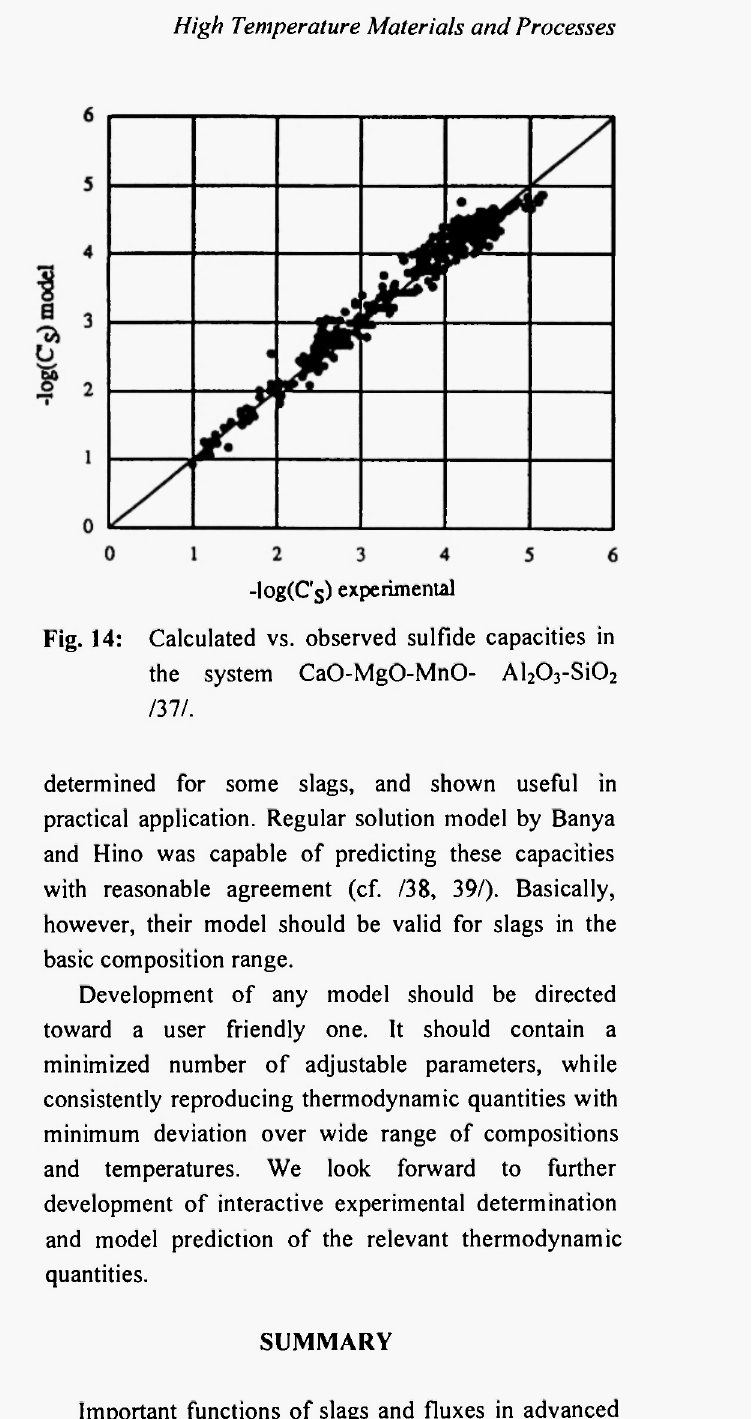
-log(C's) experimental Fig. 14: Calculated vs. observed sulfide capacities in the system CaO-MgO-MnO- Al 2 0 3 -Si0 2 mi. determined for some slags, and shown useful